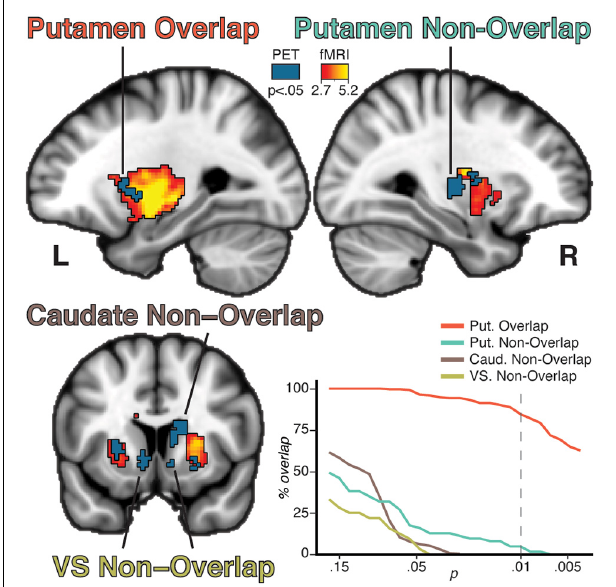
FIGURE 2 | Results from the group lp-ntPET analysis (blue solid color) and the group analysis of the fMRI GLM (red to yellow gradient). Four unique patterns of clusters were observed based on modality overlap and anatomical belonging: putamen overlap, putamen non-overlap, caudate non-overlap, and VS non-overlap. Percentage overlap of the PET clusters was calculated for different fMRI thresholds (bottom right plot). Increasing the threshold reduced the percentage intersection of the non-overlapping clusters, while the overlapping clusters remain at a high level of intersection even at more conservative thresholds. Dotted line represents the threshold used in the brain figures.